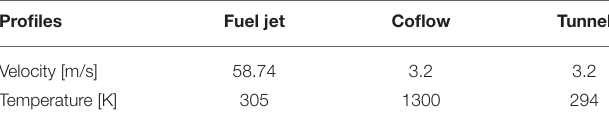
TABLE 1 | JHC inlet velocities and